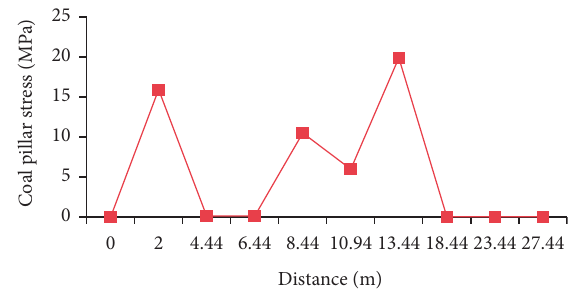
Figure 8: Internal stress curve of coal pillar.